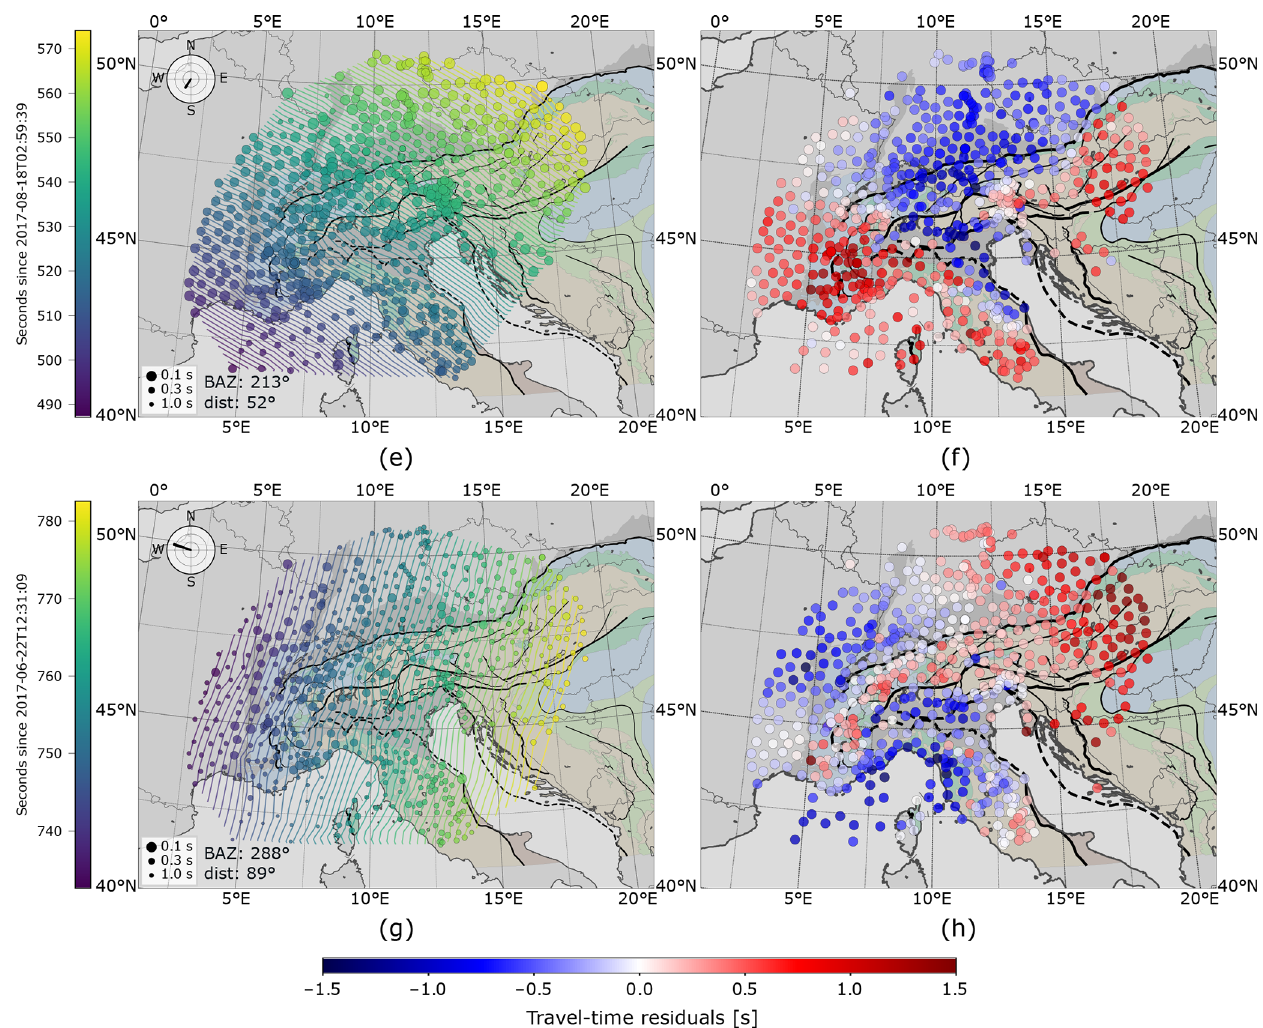
Figure 9. Wave fronts and travel-time residual patterns of different earthquakes. (a, c, e, g) Absolute travel times, distance of isolines 1s, circle sizes inversely proportional to pick uncertainty. (b, d, f, h) Demeaned travel-time residuals relative to 1D earth model. (a, b) M 6 . 6 event, 29 May 2017, Sulawesi, Indonesia, BAZ = 76 ◦ , distance = 104 ◦ ; (c, d) M 6 . 6 event, 25 November 2016, Tajikistan–Xinjiang Border Region, BAZ = 75 ◦ , distance = 45 ◦ ; (e, f) M 6 . 8 event, 22 June 2017, near the coast of Guatemala, BAZ = 213 ◦ , distance = 52 ◦ ; (g, h) M 6 . 6 event, 18 August 2017, north of Ascension Island, BAZ = 288 ◦ , distance = 89 ◦